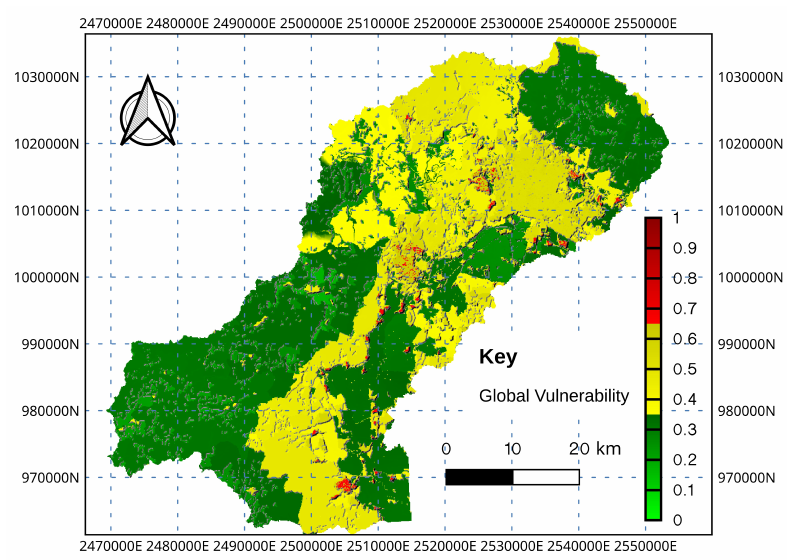
Figure 10. Global vulnerability indices in the Turbio River sub-basin (year 2022,